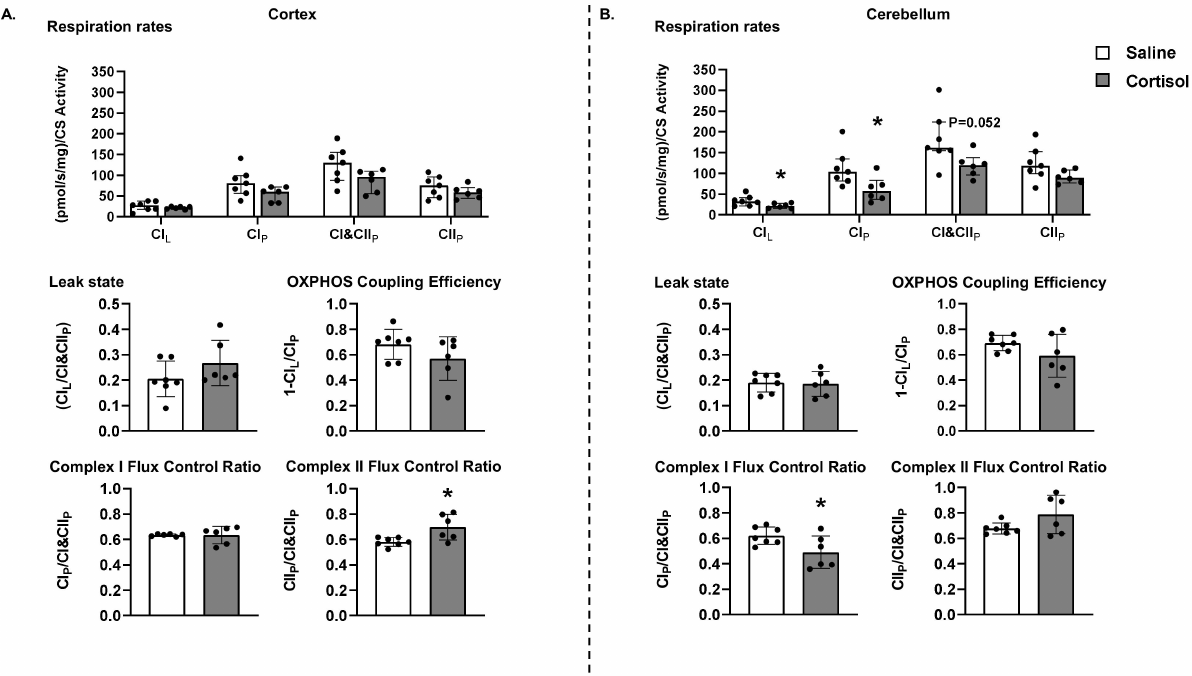
Figure 1. Mitochondrial respiratory function in the cortex and cerebellum. Data presented as median and interquartile range with individual data points (black dots) for respiratory rates relative to citrate synthase (CS) activity in the cortex ( A ) and cerebellum ( B ) for leak respiration (CI L ), Complex I-linked respiration (CI P ), CI&CII-linked respiration (CI&CII P ) and CII P -linked respiration (CII P ), leak state, oxidative phosphorylation (OXPHOS) coupling efficiency, the fraction of OXPHOS capacity attributable to CI and the fraction of OXPHOS capacity attributable to CII (CI and CII flux control ratios) from saline (open columns, n = 7) and cortisol-infused (filled columns, n = 6) fetuses at ~130 days of gestational age (dGA). * Significantly different from saline control, p < 0.05, t -test. One data point (Complex I Flux Control Ratio, control fetus) was detected as an outlier according to the ROUT method [18] and was removed from subsequent